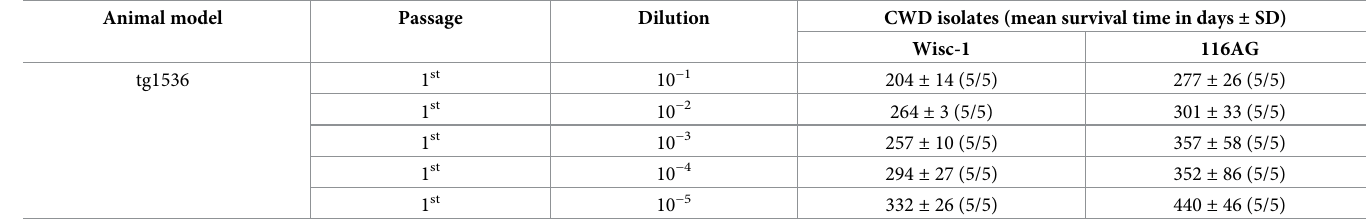
Table 2. Inoculation of tg1536 mice with serially diluted WTD isolates. Animal